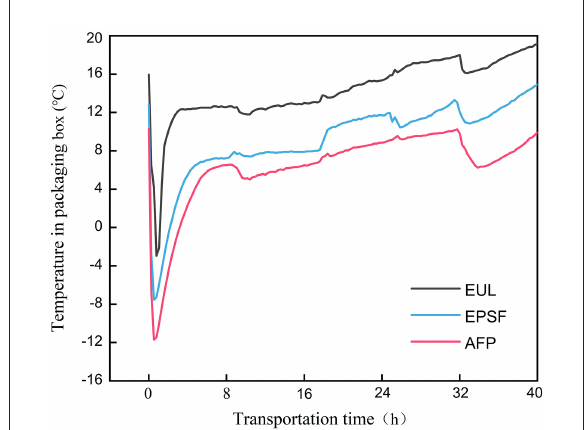
FIGURE1 Temperature changes in various logistics packaging